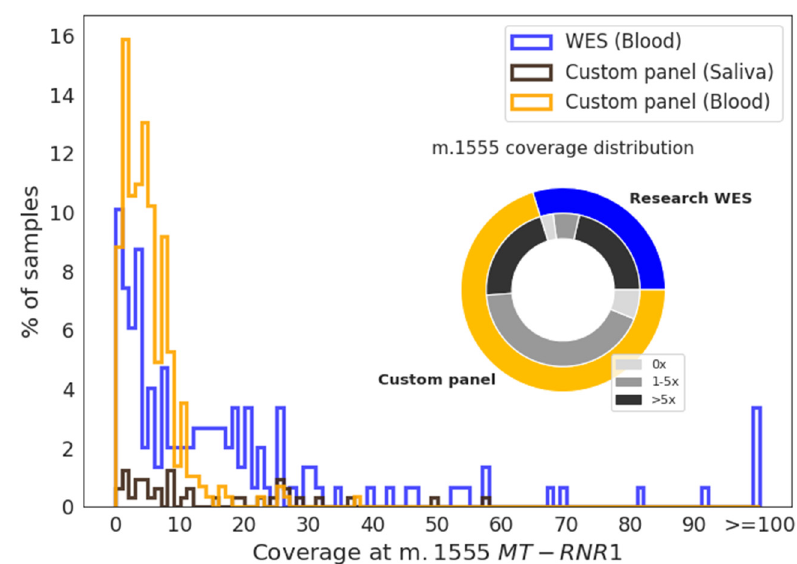
Figure 2. Coverage distribution at the m.1555 position. Histogram showing the coverage of blood samples analyzed by whole-exome sequencing (WES) (blue) or a custom gene panel (orange) and of saliva samples (dark brown) at m.1555. The pie chart shows the proportion of blood samples within each group with a coverage of 0 × , 1–5 × , or > 5 × at m.1555.